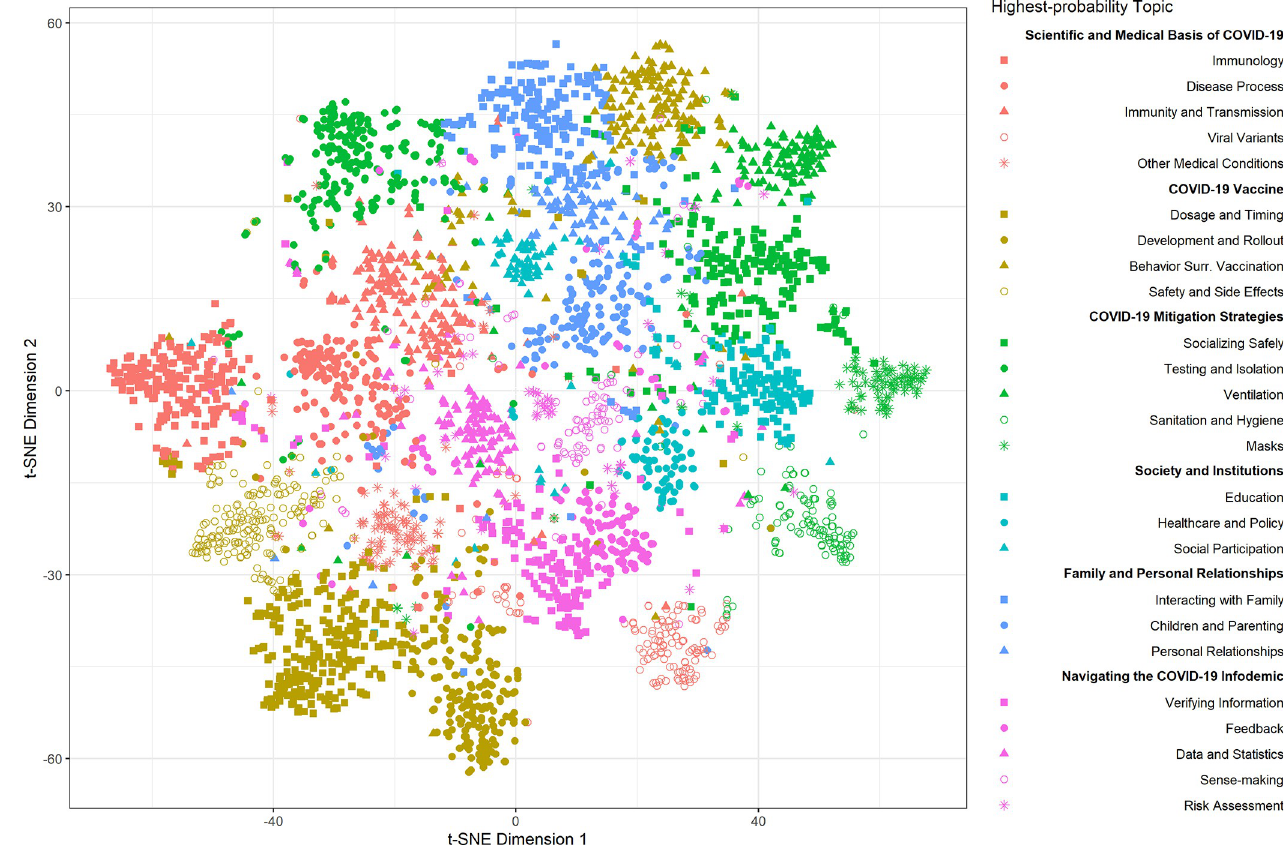
Fig 1. T-SNE visualization of submissions to the Dear Pandemic question